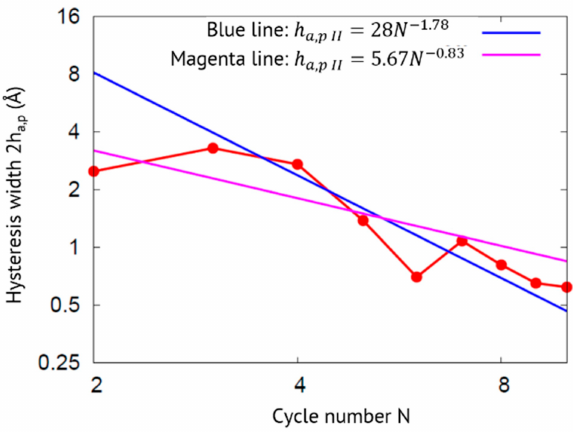
Figure 15. Dependence of the hysteresis width 2 h a,p on cycle number and fits a power-law, Equation (1). Two fits are provided to demonstrate the limits of the power-law exponents